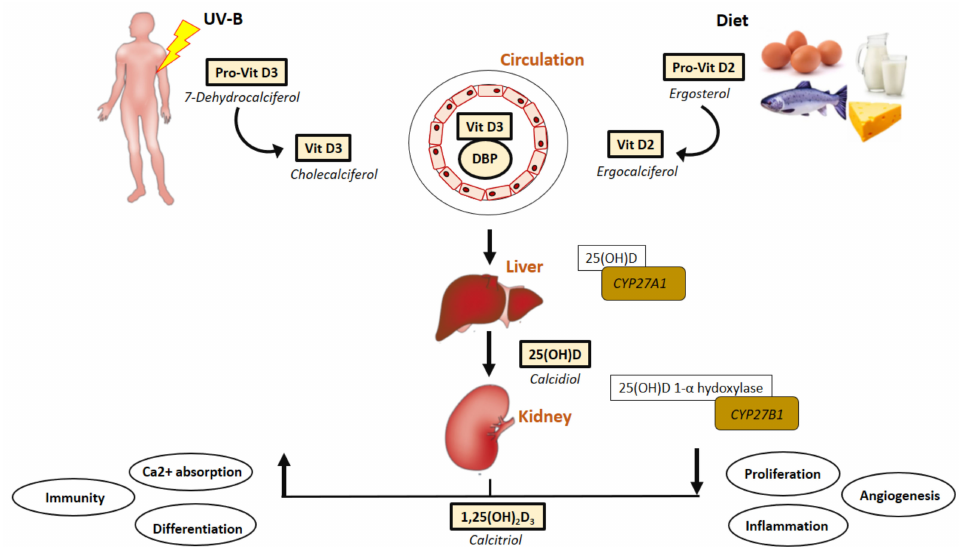
Figure 1. Schematic illustration vitamin D synthesis pathway and signalling mechanisms relevant to PAD formation. The main forms of vitamin D in nature are vitamin D3 (cholecalciferol) that is synthesized in the skin of animals and humans in response to sunlight and obtained through diet. The vitamin D3 travels in the circulation bound to DBP. Vitamin D must undergo several hydroxylation steps to become an active metabolite. The synthetic pathway involves 25- and 1-alpha-hydroxylation of vitamin D3 and D2, in the liver and kidney, respectively. The first hydroxylation occurs in the liver resulting in the formation of 25(OH)D3 or calcidiol and the second hydroxylation occurs mainly within the kidneys and intestinal epithelial cells and immune cells and generates the most biologically active hormonal form of vitamin D: 1, 25(OH) 2 D, or calcitriol. The biologically active form of vitamin D3 is involved in the regulation of numerous cell cycle regulatory mechanisms protecting the vasculature from pathological conditions. Abbreviations: Ca 2 + , calcium; DBP, vitamin D binding protein; PAD, peripheral arterial disease; Vit D3, vitamin D3